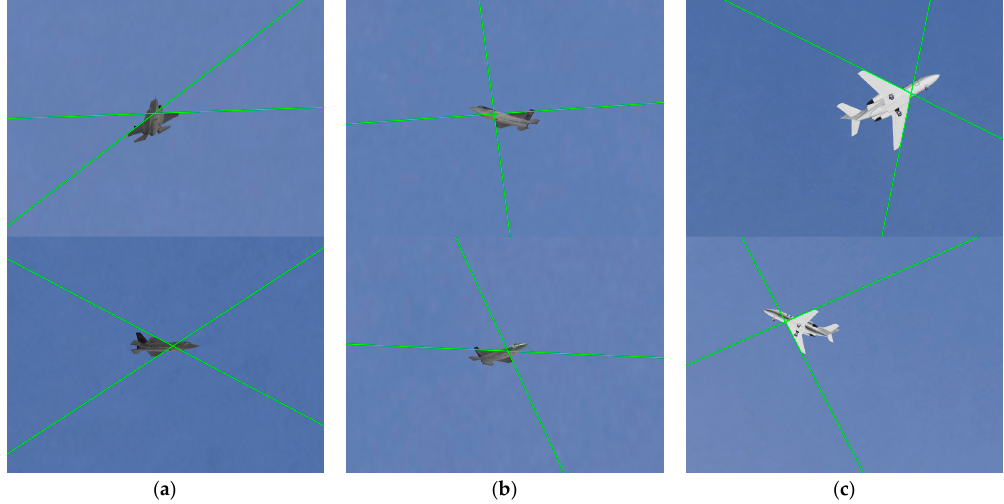
Figure 12. Wing leading edge line extraction results: ( a ) the results on an image pair of F35 model in scene 1 (Figure 11a); ( b ) the results on an image pair of F35 model in scene 2 (Figure 11b); ( c ) the results on an image pair of Cessna model in scene 2 (Figure 11c).